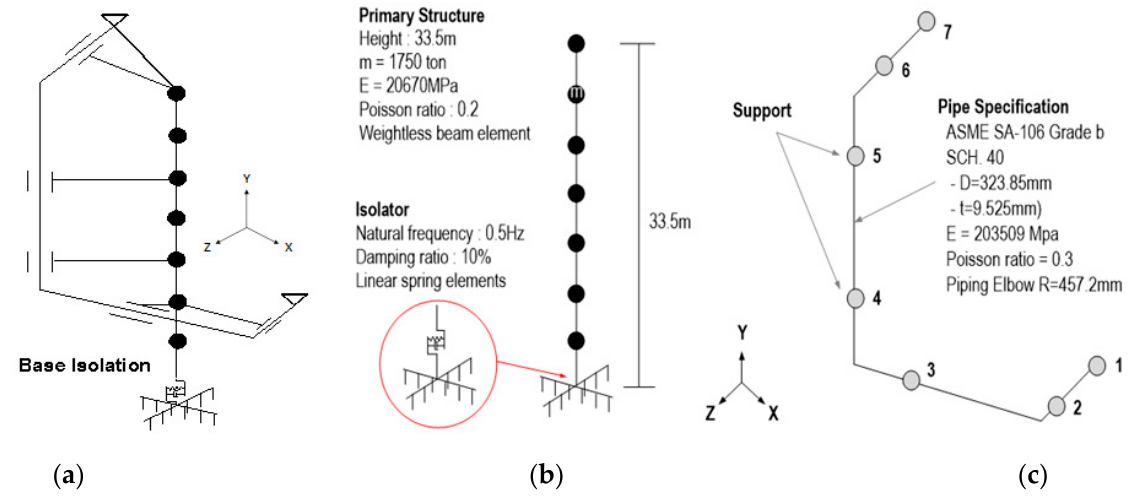
Figure 7. Isolated containment structure and piping system: ( a ) connection of the isolated structure and piping system; ( b ) isolated containment structure; ( c ) piping system.